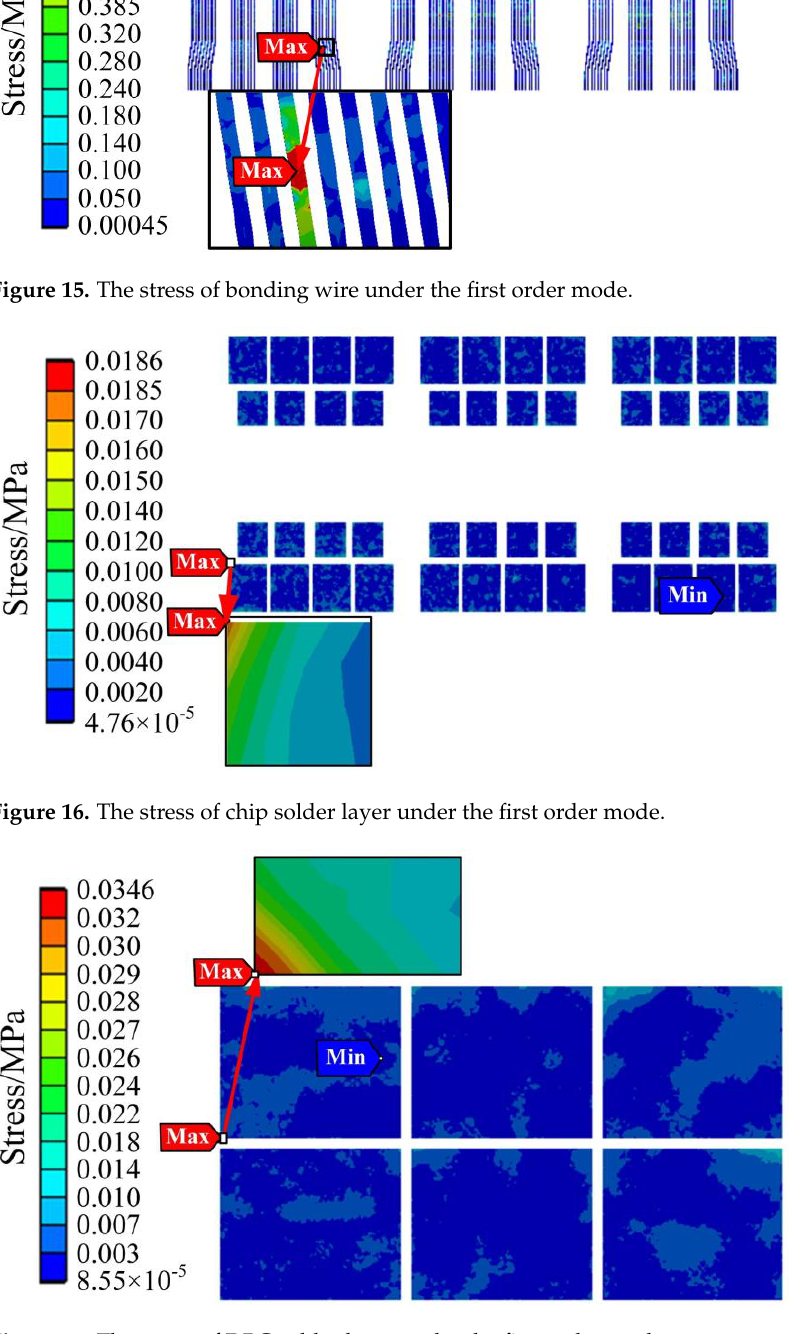
Table 6. The natural frequency under the constraint condition.